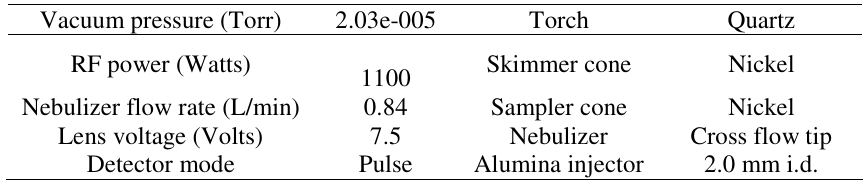
Table 1. Instrumental operating conditions for